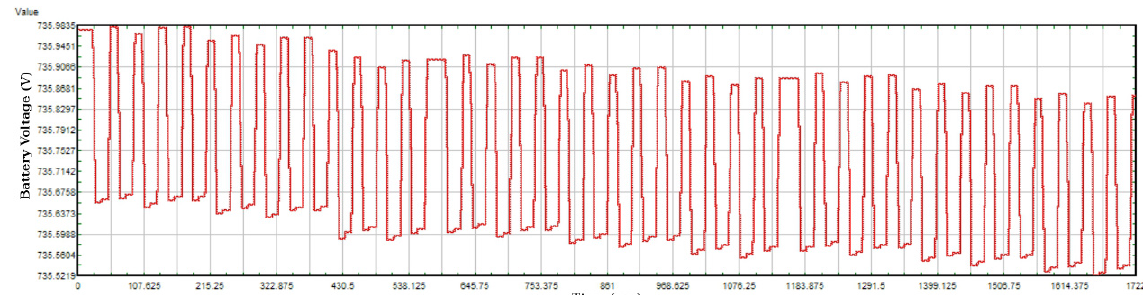
Figure 9. Voltage of battery in PHEV